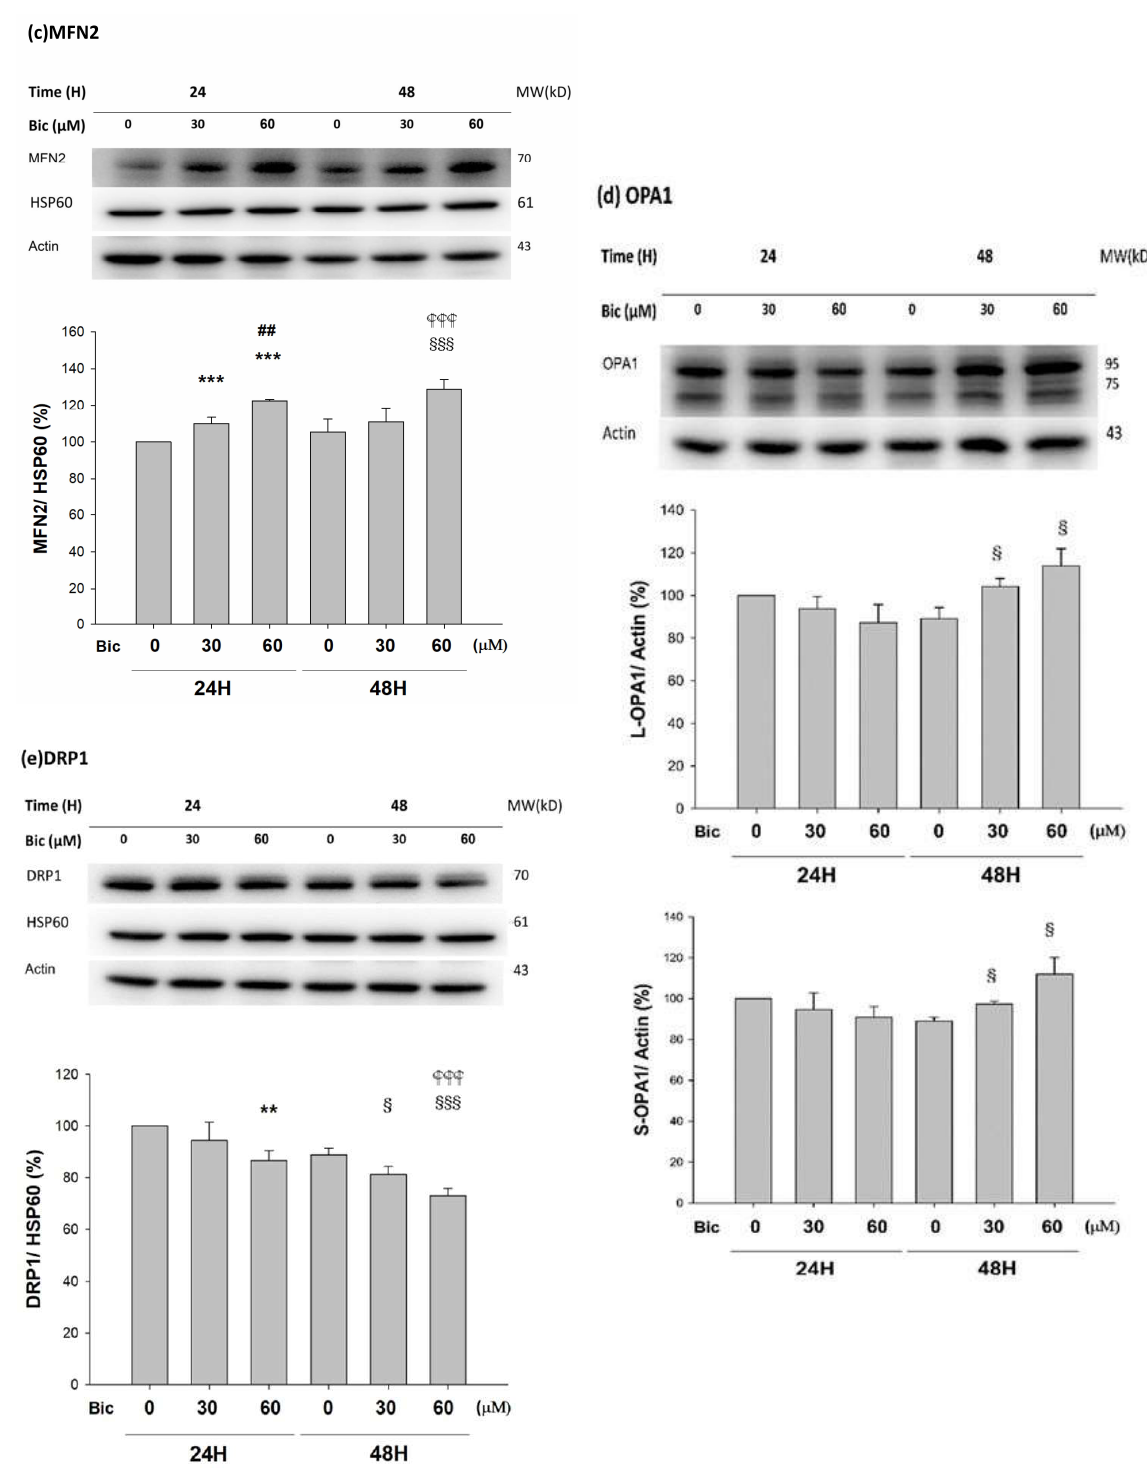
Figure 8. Representative western blot and densitometric analysis showing level of PGC1 α ( a ), MFN1 ( b ), MFN2 ( c ), OPA1 long form (L-OPA1, 95kD) and short form (S-OPA1, 75kD) ( d ), and DRP1 ( e ) proteins in RMC cells following 0, 30, and 60 µ M of bicalutamide treatment for 24 and 48 h. β -Actin Figure 4. Bicalutamide induces mitochondria respiratory complex I deficiency. Representative west- is as cytosolic normalization control; HSP60 is as mitochondrial normalization control. Bar graph ern blot and densitometric analysis showing level of NDUFB8 proteins in RMC cells following 0~60 represents the mean ± SD of triplicate experiments: * p < 0.05, ** p < 0.01 *** p < 0.001 compared to Bic μ M of bicalutamide treatment for 24 and 48 h ( β -Actin is shown as normalization control). Bar graph 0 µ M at 24 h. ## p < 0.01 compared to Bic 30 µ M at 24 h. § p < 0.05, §§ p < 0.01, §§§ p < 0.001 compared represents the mean ± SD of three independent experiments: §§§ p < 0.001 compared to Bic 0 μ M at p < 0.001 compared to Bic 30 µ M at 48 to Bic 0 µ M at 48 h. 48 h.  p < 0.001 compared to Bic 30 μ M at 48 h ( a ). RMC cells were treated with 0~60 μ M of bicalutamide for 48 h and subjected to immunofluorescence stain ( b ) and activity assay of complex I at 48 h ( c ). Here, 0.25 μ M of rotenone is shown as positive control for complex I inhibition. Bar